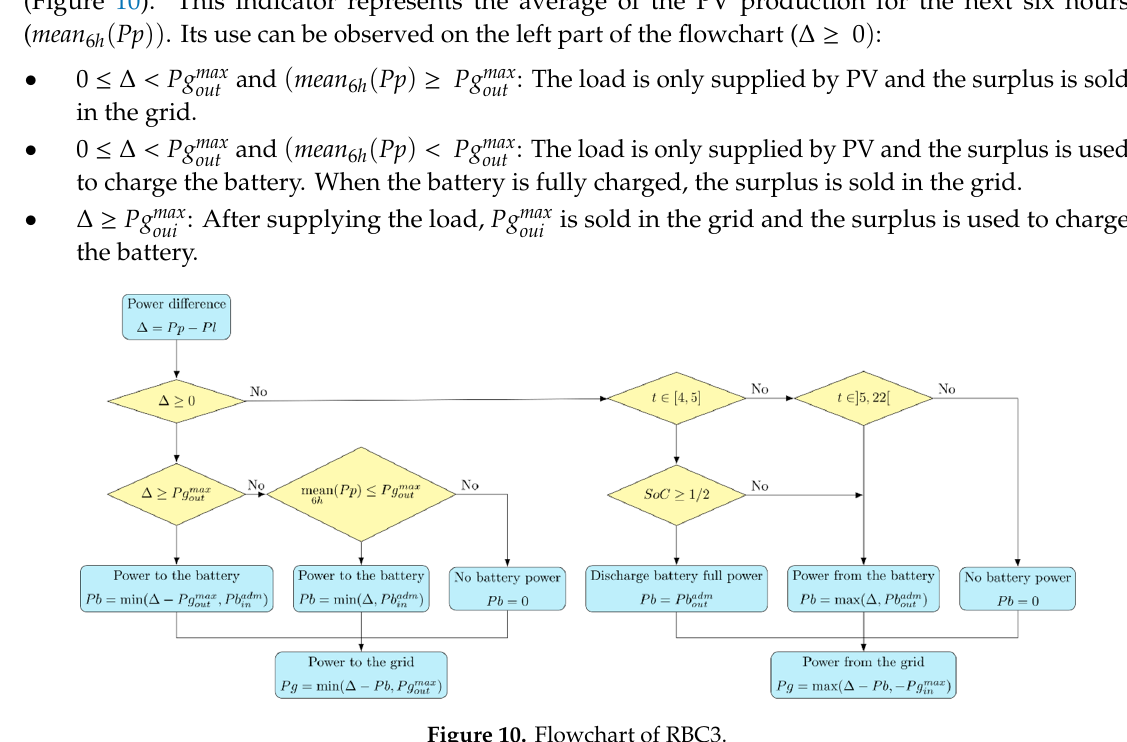
Figure 9. Flowchart of RBC2.